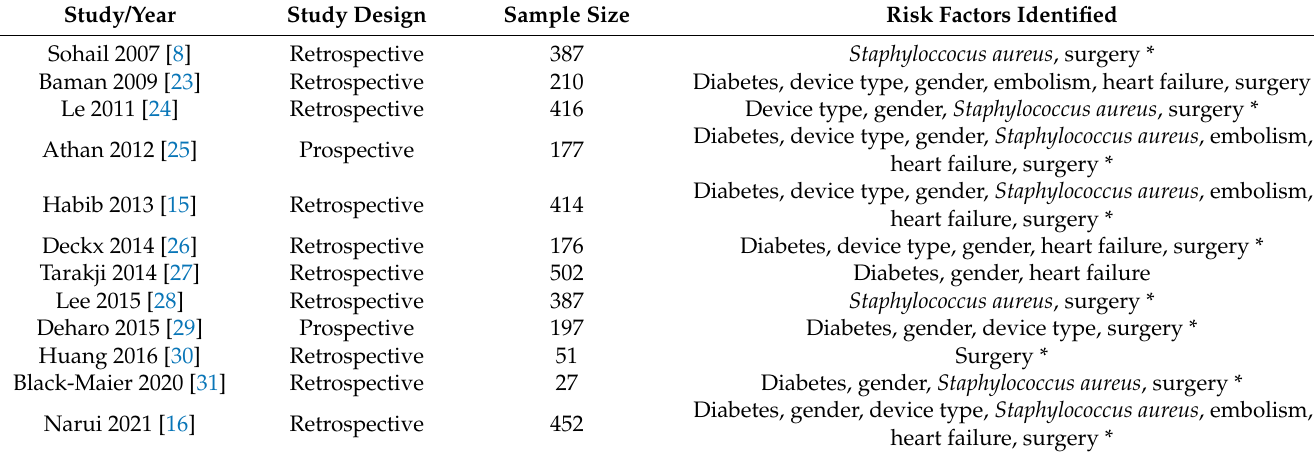
Figure 1. Flowchart outlining study selection process. Table 1. Characteristics of the included